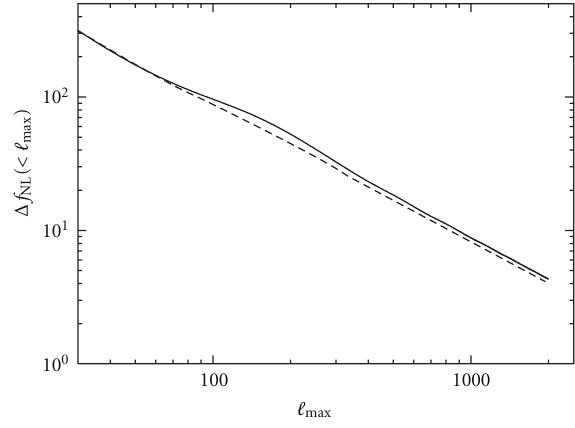
Figure 4: The cross-correlation coe ffi cient between the second- order bispectrum from the products of the first-order terms and the local primordial bispectrum.